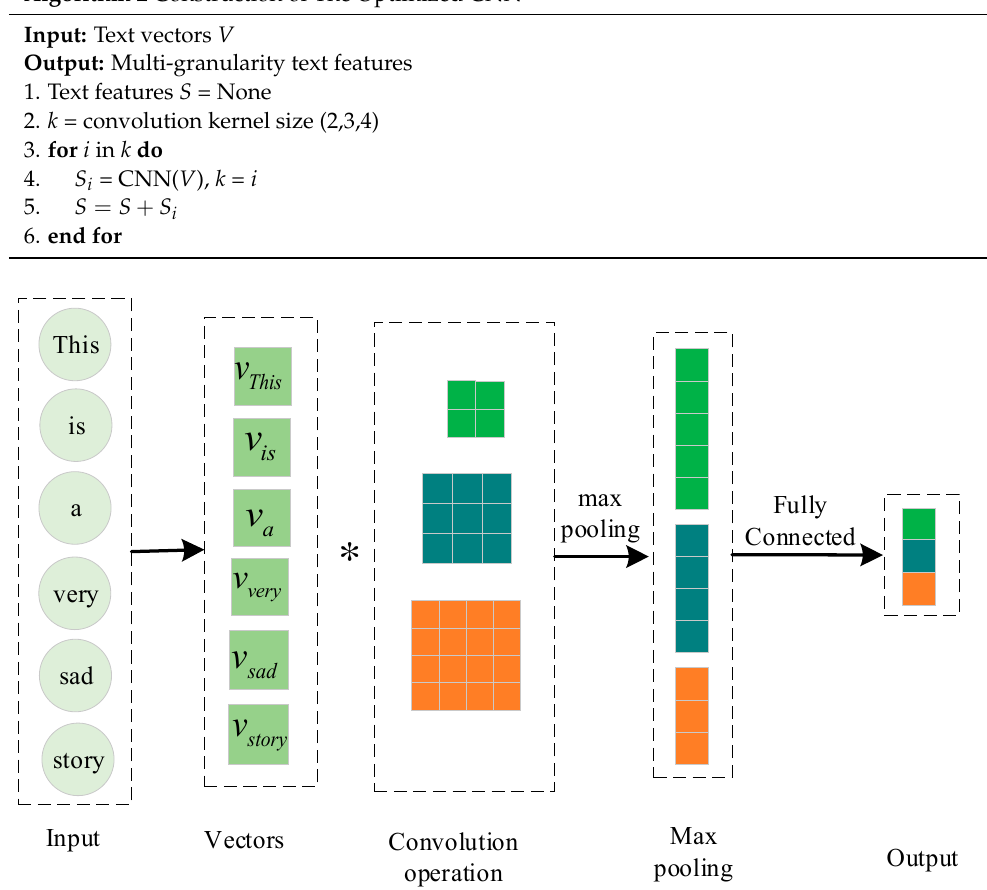
Algorithm 2 Construction of The Optimized CNN